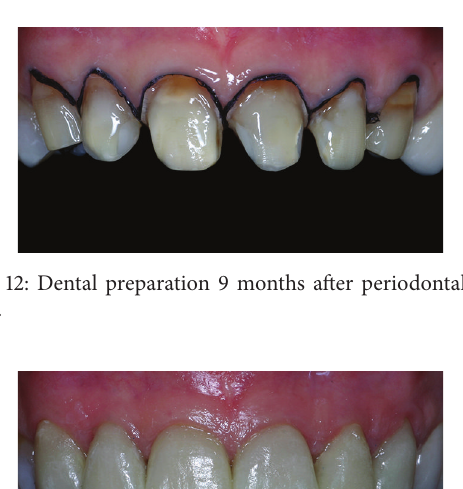
Figure 11: Soft tissue health 3 months after surgery.